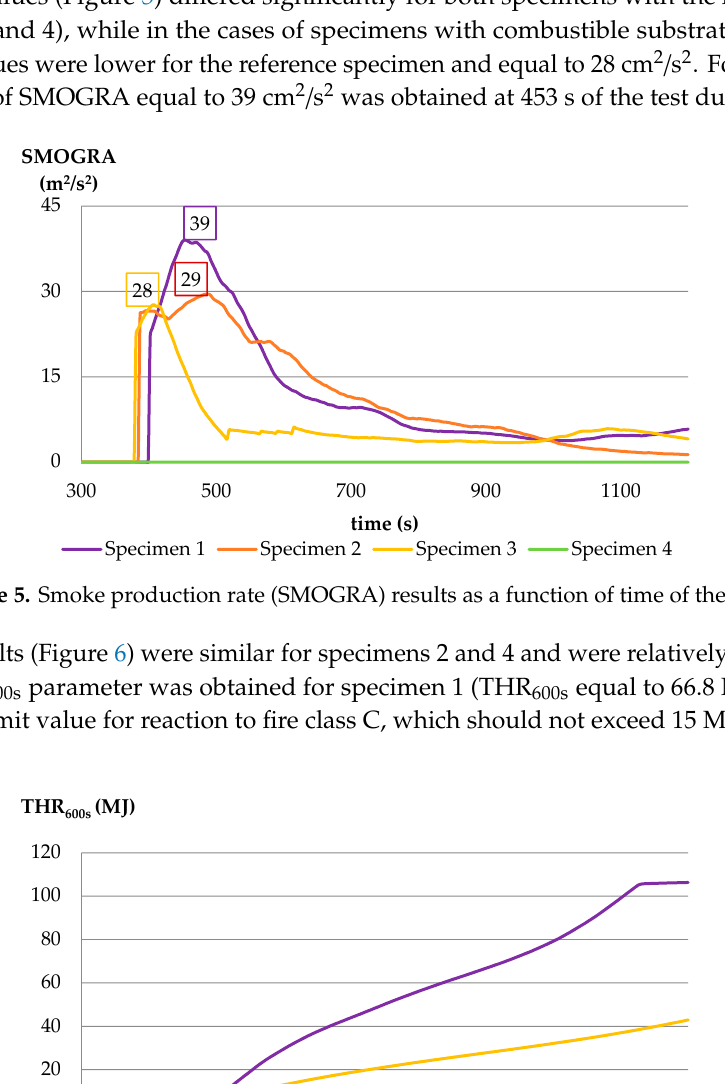
Figure 4. The comparison of the fire grown rate (FIGRA 0.2MJ ) results as a function of time at the SBI test.